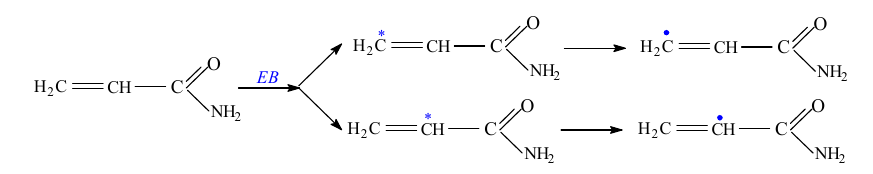
Figure 6. Possible mechanism for obtaining radicals by irradiation from acrylamide.